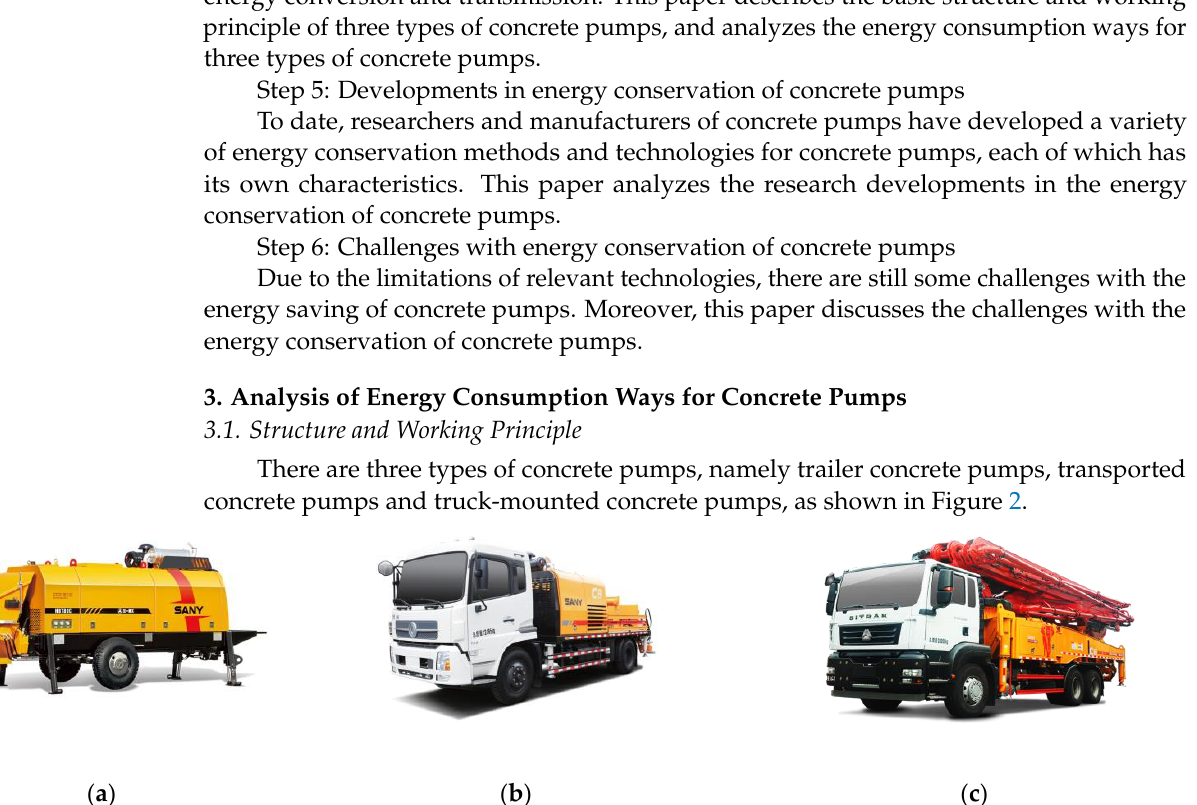
Figure 2. Three types of concrete pumps. ( a ) Trailer concrete pumps [27]. ( b ) Transported concrete pumps [28]. ( c ) Truck-mounted concrete pumps [29].